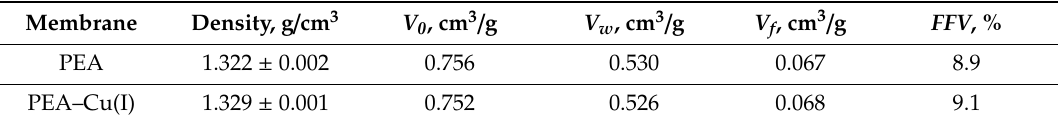
Table 1. Data on density and free volume parameters.